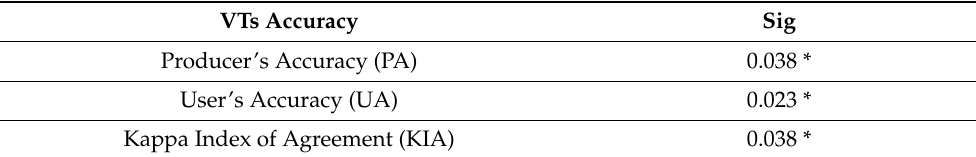
Table 4. Results of the statistically significant comparison of multi-temporal images and single-date images in VTs